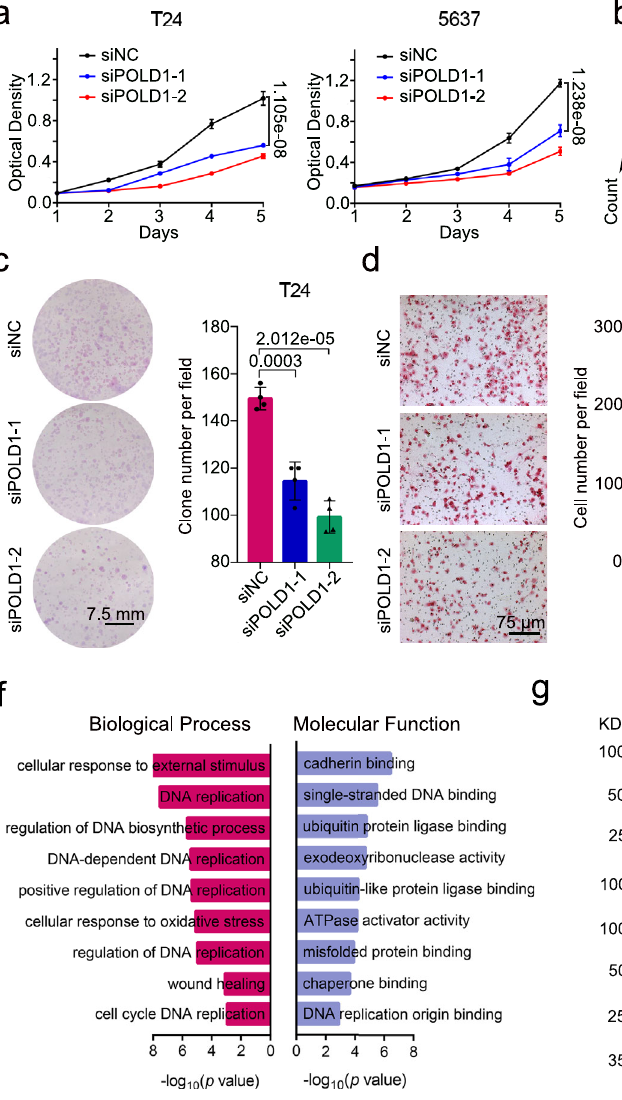
Fig. 2 | POLD1 promotes BLCA proliferation and metastasis in vitro. a The cell proliferationcurve of T24and 5637cells with POLD1 knockdown. Beforedetecting the absorbance, 20 μ L of MTT was added to the 96-well seeded with cells, and incubatedina37°Ccellincubatorfor4h.Then,200 μ LofDMSOwasaddedtoeach well and shaken until homogenized. Graph shows mean±SD, n =6 biologically independent experiments in each group. b Flow cytometric analysis of DNA con- tent for cell cycle progression from propidium iodide (PI, 100 μ g/mL) staining of T24cellswithorwithout POLD1 depletion. c Representativeimages(leftpanel)and statistical graph (right panel) of clone formation assays from the indicated groups with POLD1 depletion in T24 cells ( n =4 biologically independent experiments in eachgroup). d Representativeimages(leftpanel)and cellnumbers(rightpanel)of Transwell assays from the indicated groups with or without POLD1 knockdown in T24 cells ( n =3 biologically independent experiments in each group).